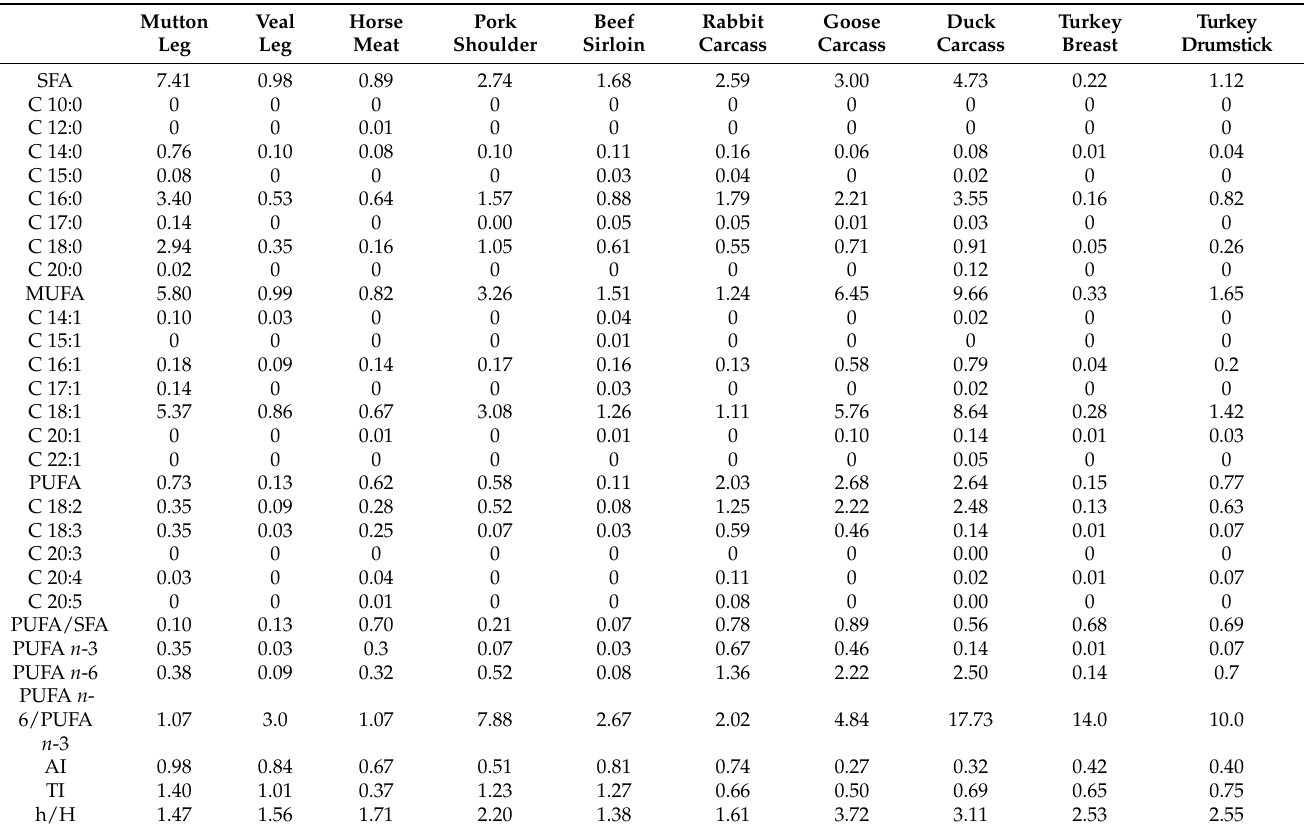
Table 4. Fatty acids content of meat (g/100 g edible portion).